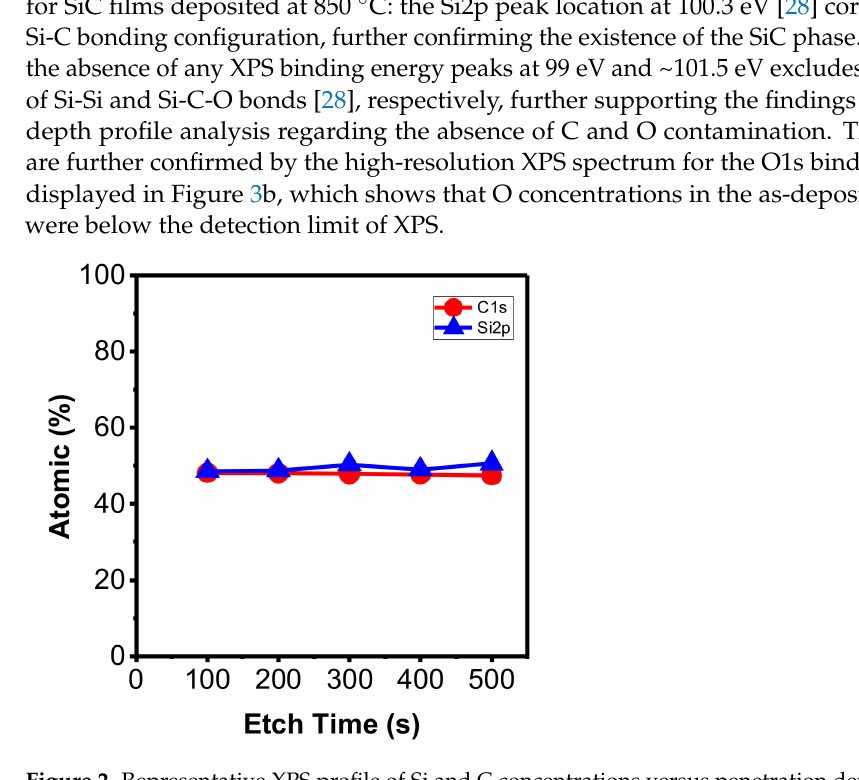
Figure 2. Representative XPS profile of Si and C concentrations versus penetration depth in SiC films deposited at 850 ◦